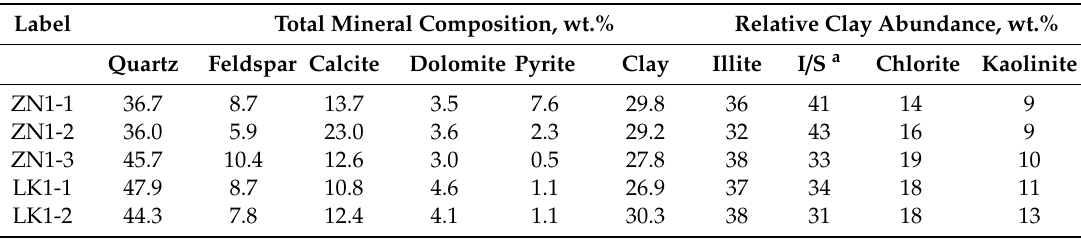
Table 2. The results of mineral composition